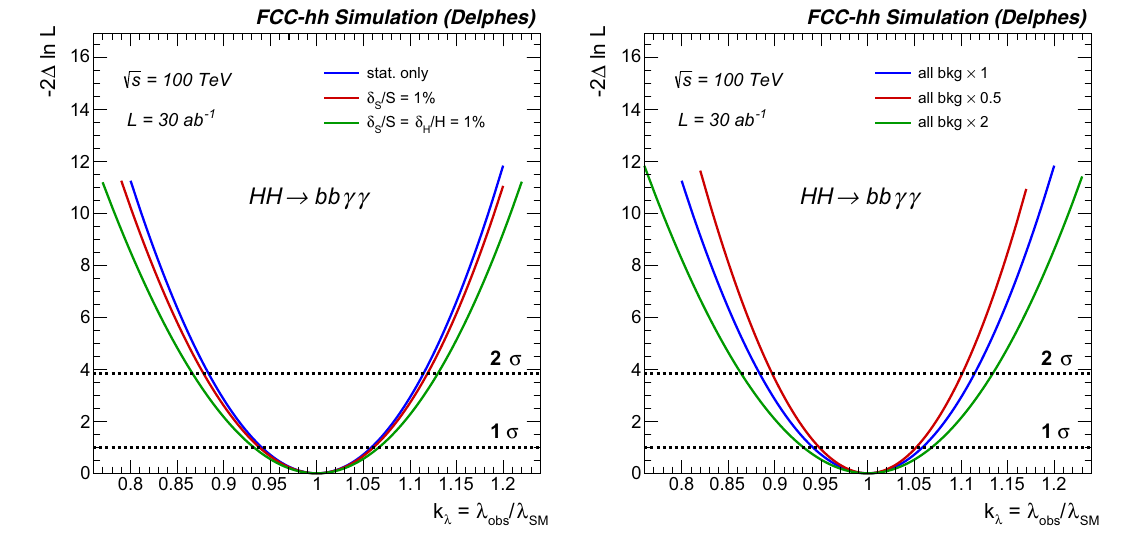
Fig. 10.4 Expected precision on the Higgs self-coupling modifier κ λ with no systematic uncertainties (only statistical), 1% signal uncertainty, 1% signal uncertainty together with 1% uncertainty on the Higgs backgrounds (left) and assuming respectively × 1, × 2, × 0 . 5 background yields (right).)